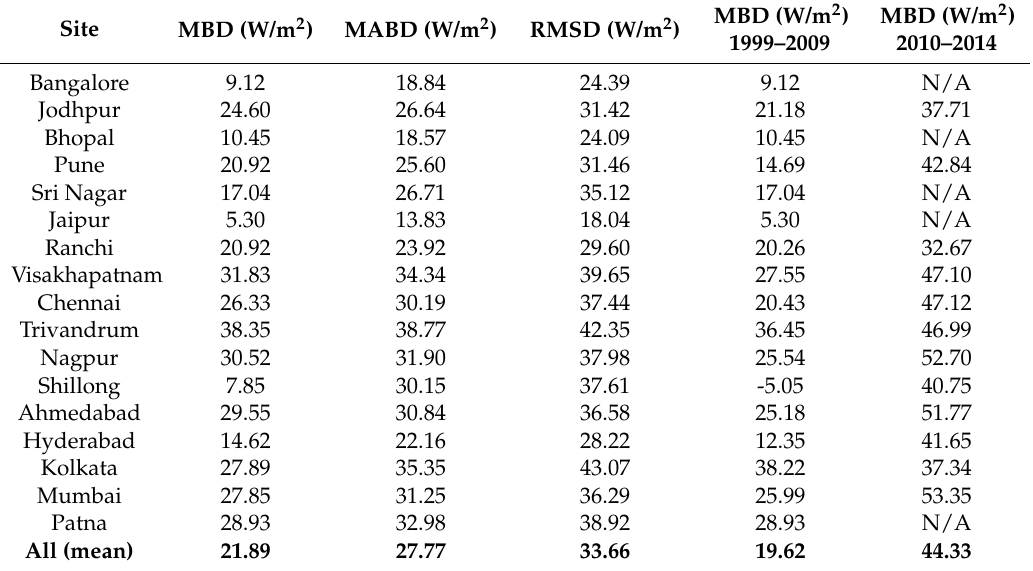
Table 2. Validation metrics for all sites (QA method: conservative).